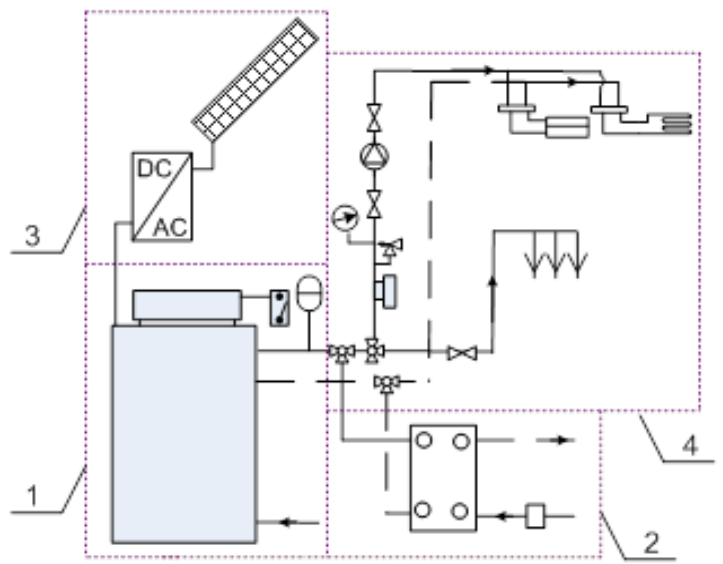
Figure 1. Schematic diagram of the system: 1—heat pump; 2—district heating; 3—photovoltaics; 4—building technology.